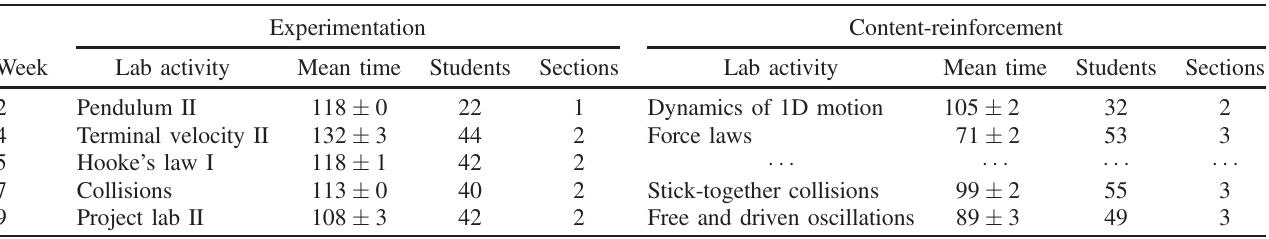
TABLE IX. Mean time reported with standard errors in minutes for students to complete each lab used in the calculations of mean time in